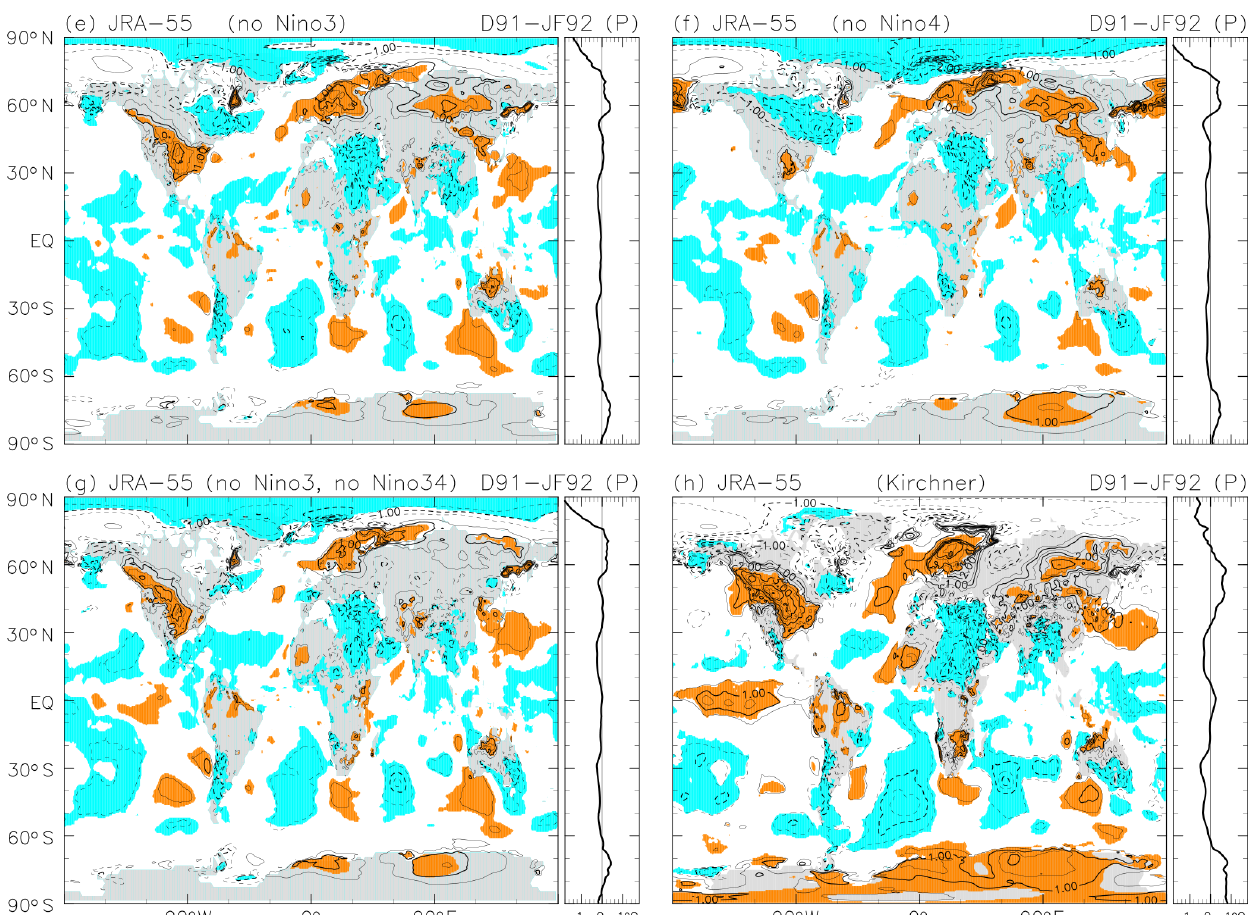
Figure B1. Similar to Fig. A1, but for the anomalies averaged from December 1991 to February 1992 following the Mount Pinatubo eruption using JRA-55 and with changes to panels (b) – (e) and with additions of panels (f) – (h) . (a) The primary result as in Fig. 3a, (b) the result using the primary method but without the El Niño Modoki index, (c) the result using the primary method but without the Niño 1 + 2 index, (d) the result using the primary method but without the Niño 3.4 index, (e) the result using the primary method but without the Niño 3 index, (f) the result using the primary method but without the Niño 4 index, (g) the result using the primary method but without the Niño 3 and Niño 3.4 indices, and (h) the anomalies with respect to the 1979–1993 means (for the same months of year) following Plate 1c of Kirchner et al. (1999). See text for the details of each method. The contour interval is 0.5K, without 0.0K lines. Coloured shading in (a) – (g) denotes anomalies that are positive (orange) or negative (blue) with absolute magnitudes larger than 1 SD of the 3-month mean R(t) . Coloured shading in (h) has a similar meaning but with anomalies evaluated against the SD of December–January–February (DJF)-mean data during